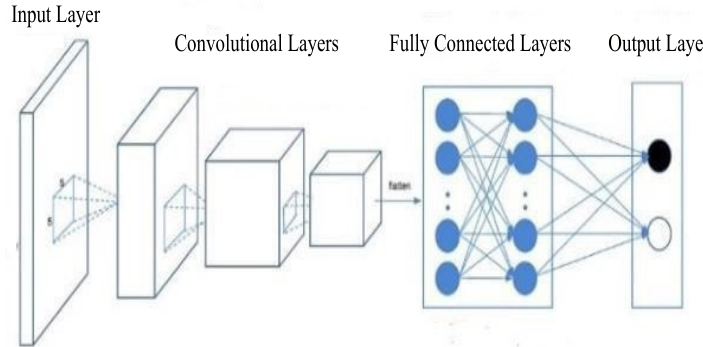
Figure 4. CNN Model Layers.